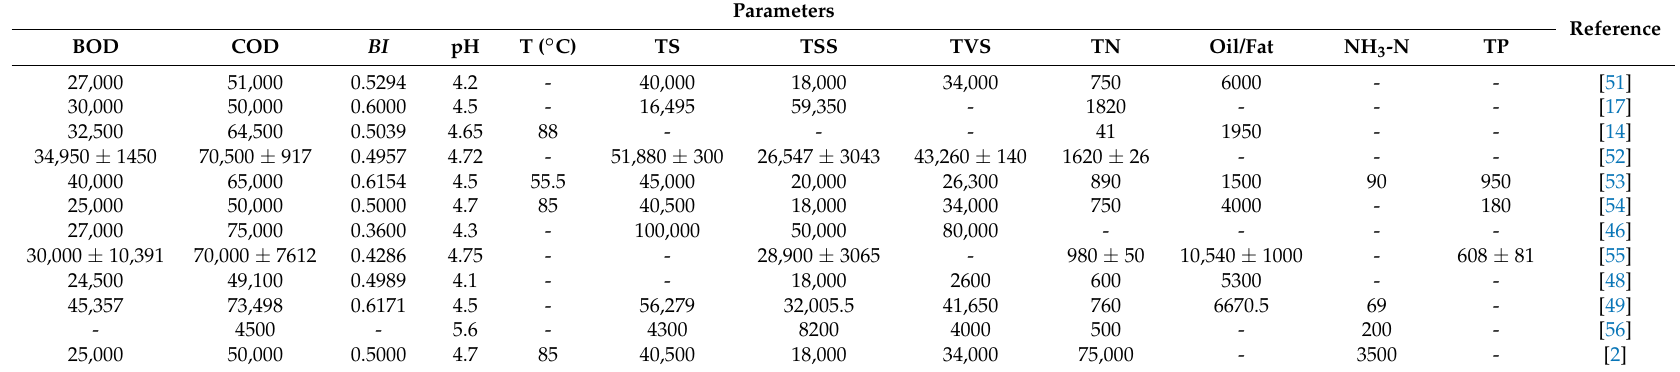
Table 1. Published information on physicochemical properties and biodegradability index (BI) of palm oil mill effluent (POME).